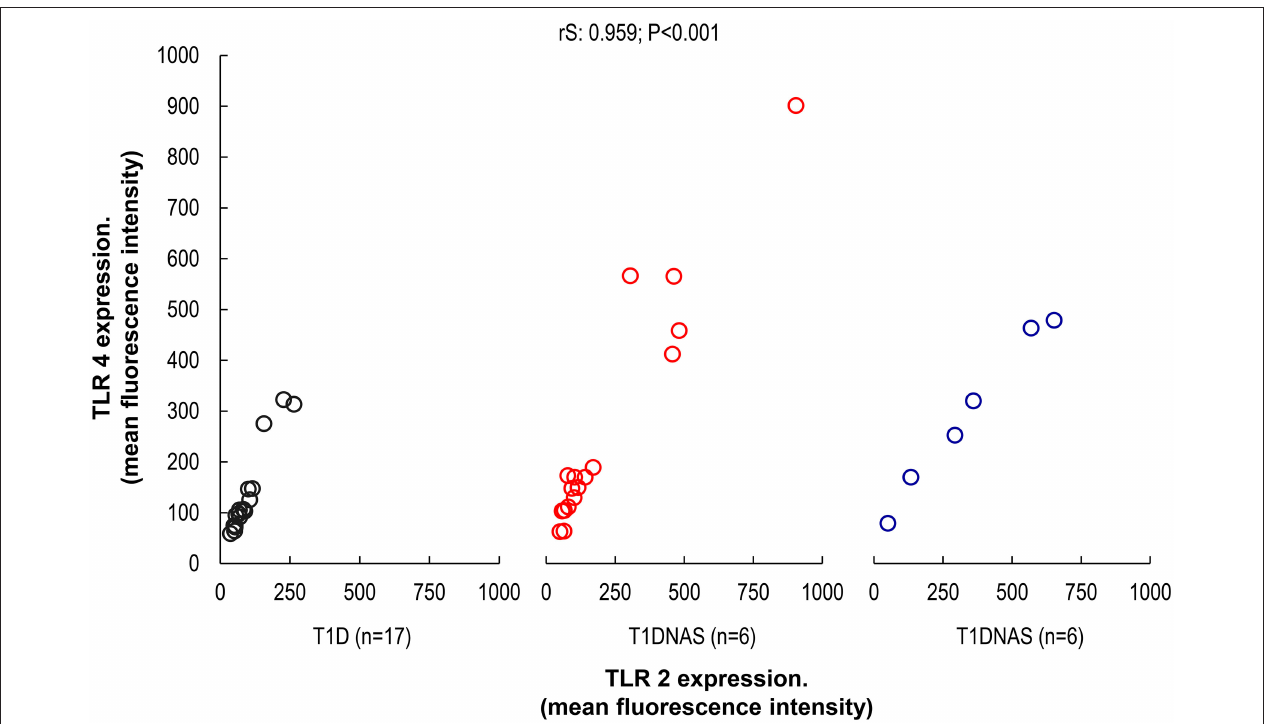
FIGURE 2 | Correlation between TLR2 and TLR4 expression in monocytes by mean fluorescence intensity (MFI) in control subjects ( N = 17), type 1 diabetes patients (T1D) ( N = 17) from multiplex families and their non-affected siblings (T1DNAS) ( N = 6) rS: 0.959; P <